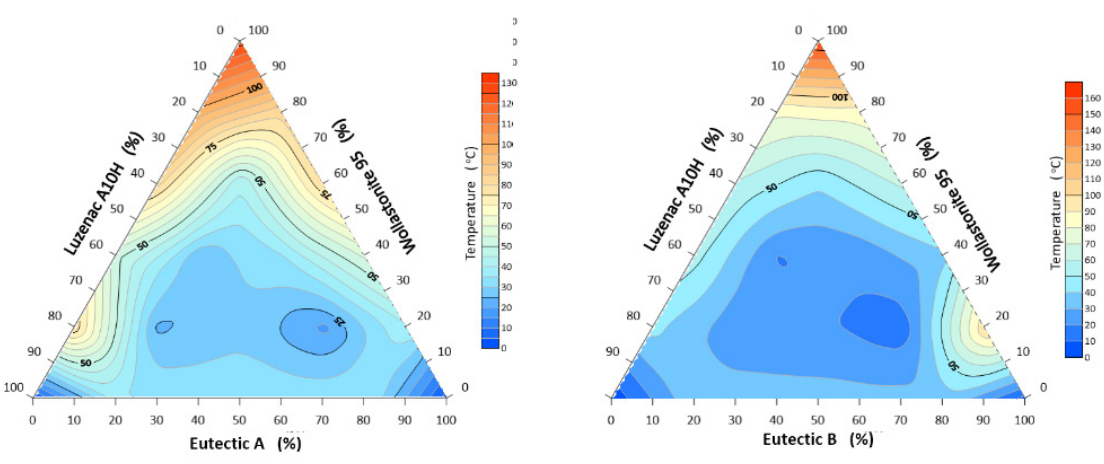
Figure 5. Sintering interval of the system: A/B-eutectic–Luzenac A10H–Wollastonite 95.